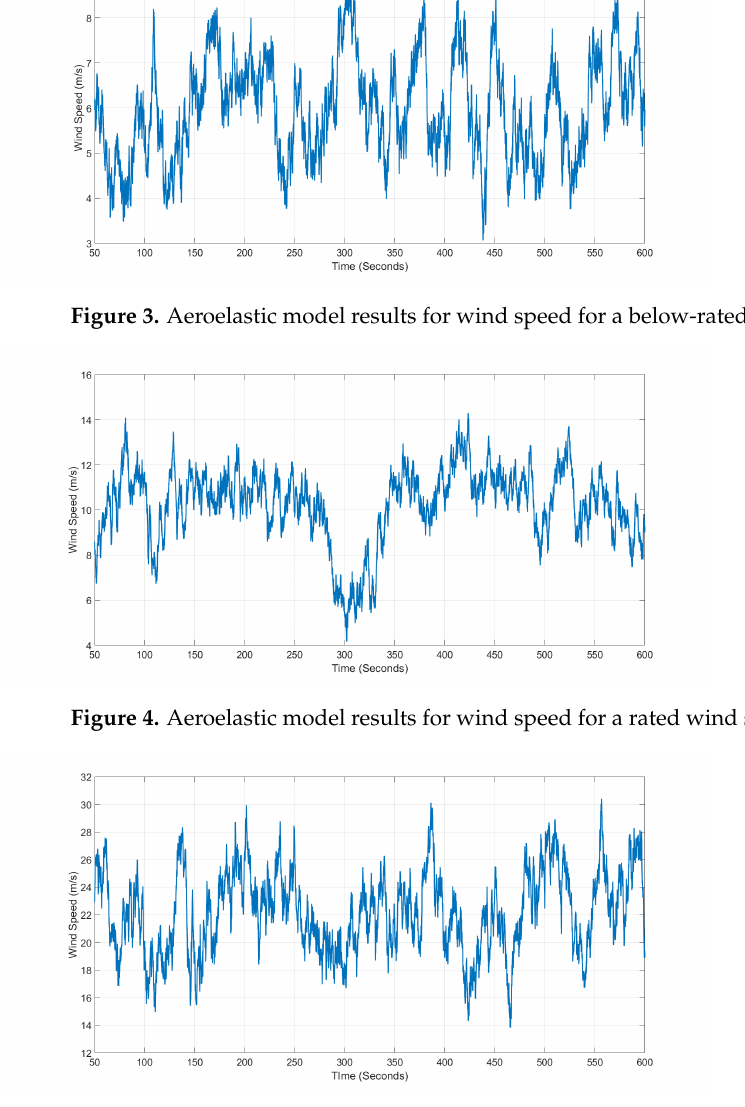
Figure 5. Aeroelastic model results for wind speed for an above-rated wind speed of 22